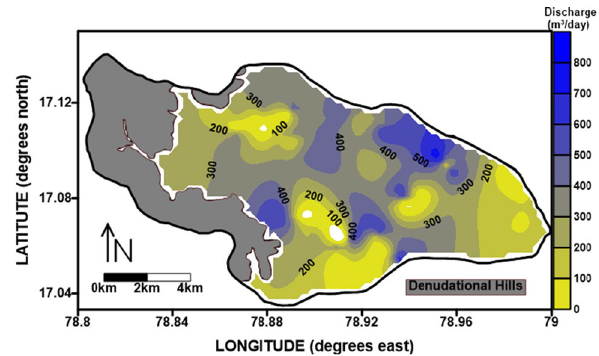
Fig. 6 Map showing the radius of influence (meters) of each pumping test wells